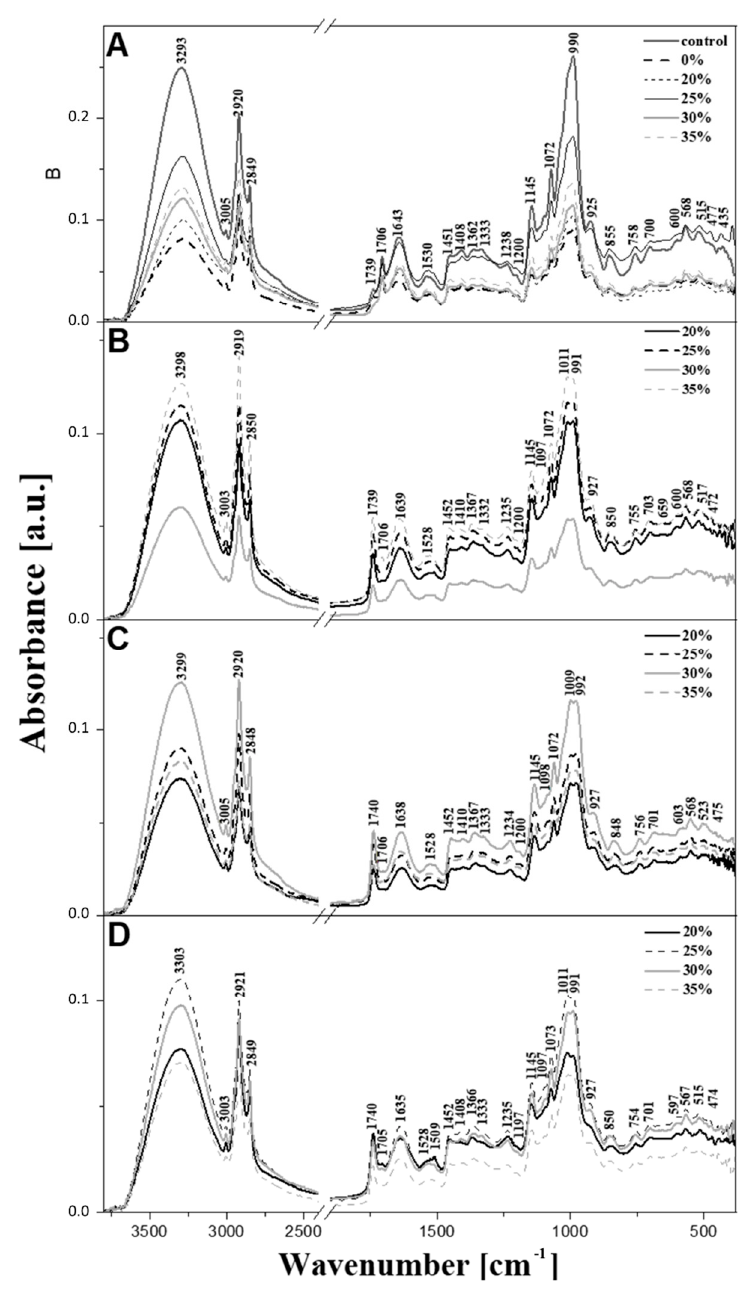
Figure 8. The FTIR infrared spectra for the samples selected for testing presented in the range from 400 to 3700 cm − 1 . Panel ( A ): pelleted corn bran; Panel ( B ): extruded corn bran—70 rpm; Panel ( C ): extruded corn bran—90 rpm; Panel ( D ): extruded corn bran—110 rpm.